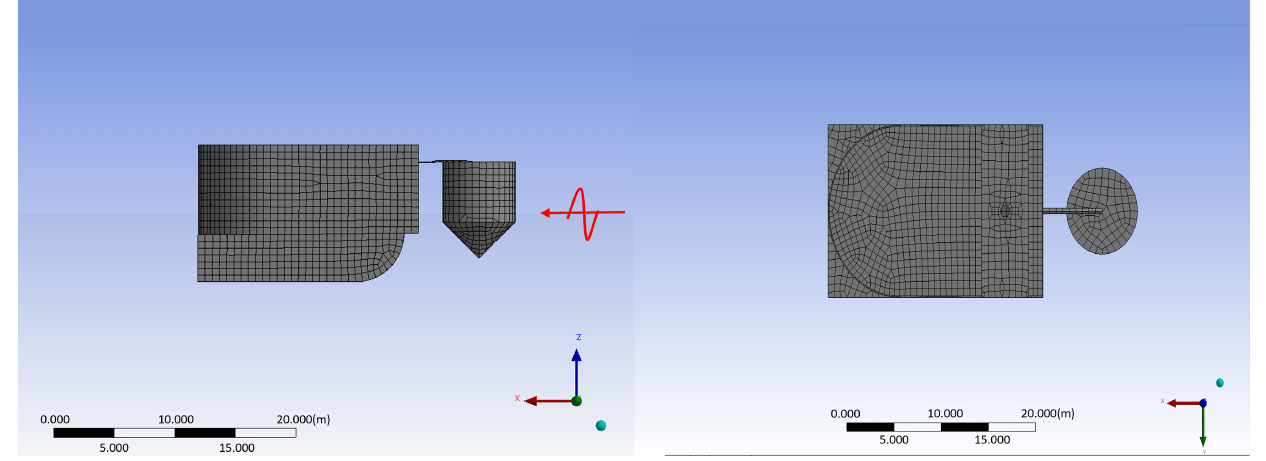
Figure 11. Geometry of the Hybrid